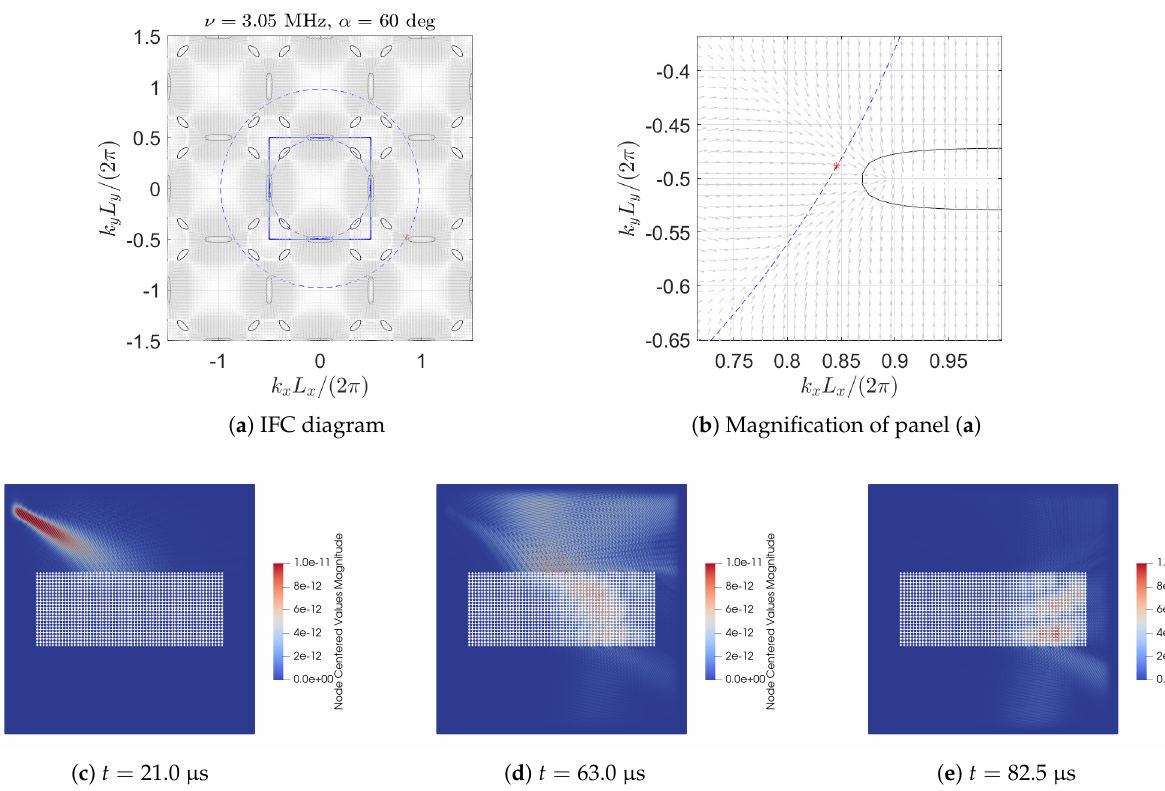
Figure 6. Scattering of a shear-dominated Gaussian beam at centre frequency f = 3.05 MHz and an angle of incidence α = 60 ◦ . Panels ( a , b ) show the IFC diagram (and its magnification); the red asterisk represents the intersection point of the Gaussian beam propagation direction and the isofrequency contours. Panels ( c – e ) show the magnitude of the displacement field at different times in the FE simulation, with the total time being T = 120 µ